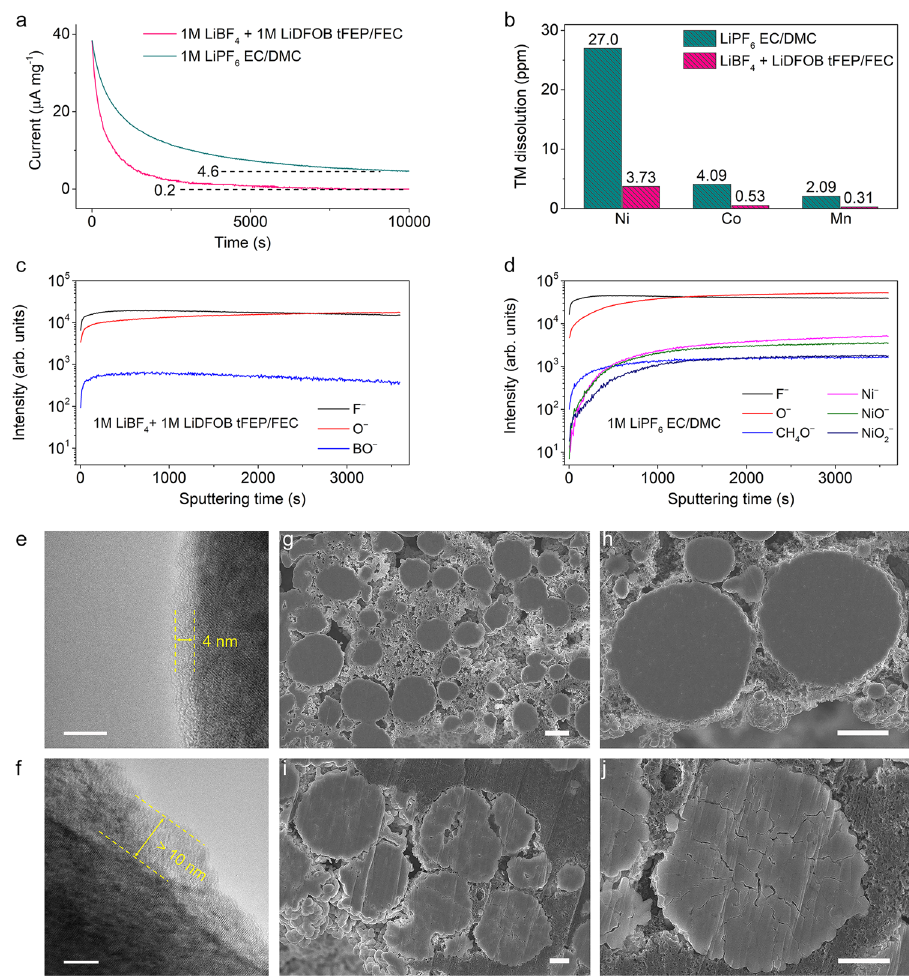
Fig.5|Characterizationsofcathodechemistrywith4.6Vcut-offvoltagein1M LiBF 4 +1M LiDFOB tFEP/FEC and 1M LiPF 6 EC/DMC electrolyte. a Leakage currents during the 4.6V constant-voltage fl oating test of the NMC811 cathodes cycled in various electrolytes for 3 cycles. b Transition metal (TM) dissolution measured by inductively coupled plasma mass spectrometry (ICP-MS) after 100 cycles. TOF-SIMS characterization of the cycled NCM811 cathodes retrieved from thepouchcellsafter100cycles.Normalizeddepthpro fi lesofinterphasialandbulk